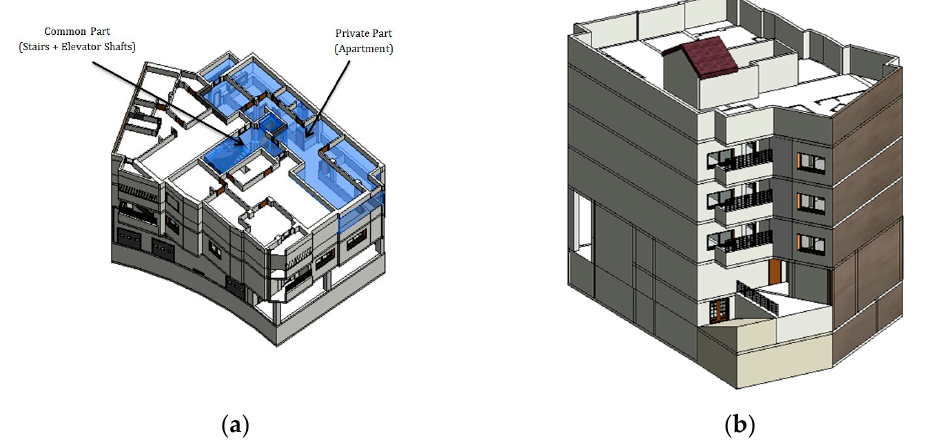
Figure 12. ( a ) Representation of legal objects within BIM; ( b ) The resulting BIM textured in Revit.